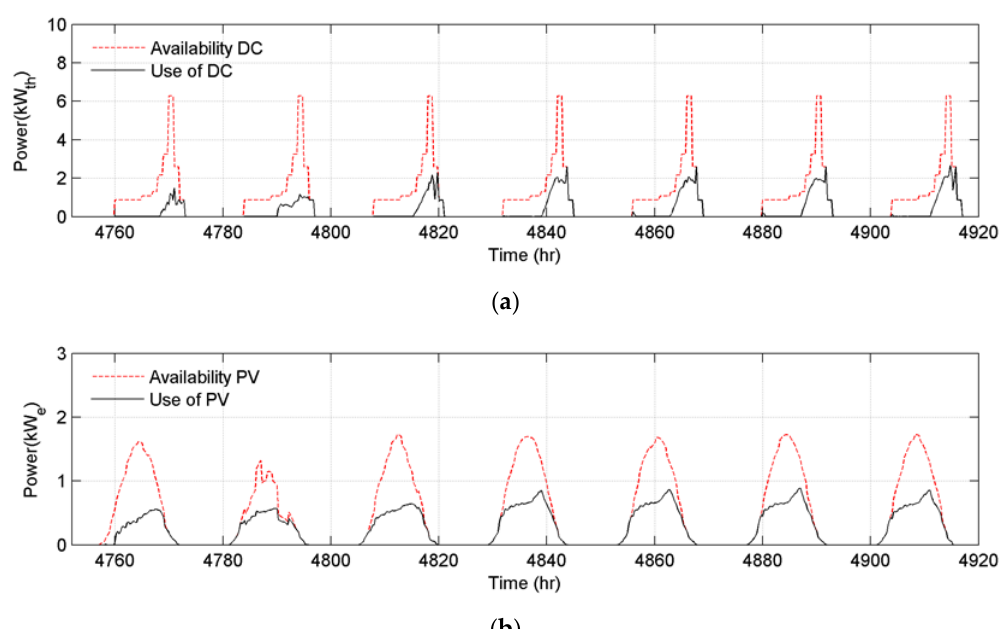
Figure 16. Energy sources used to cover the weekly cooling demand of the building compared to the availability profiles with MPC (OF P , PH of 18 h): ( a ) DC; ( b ) PV.